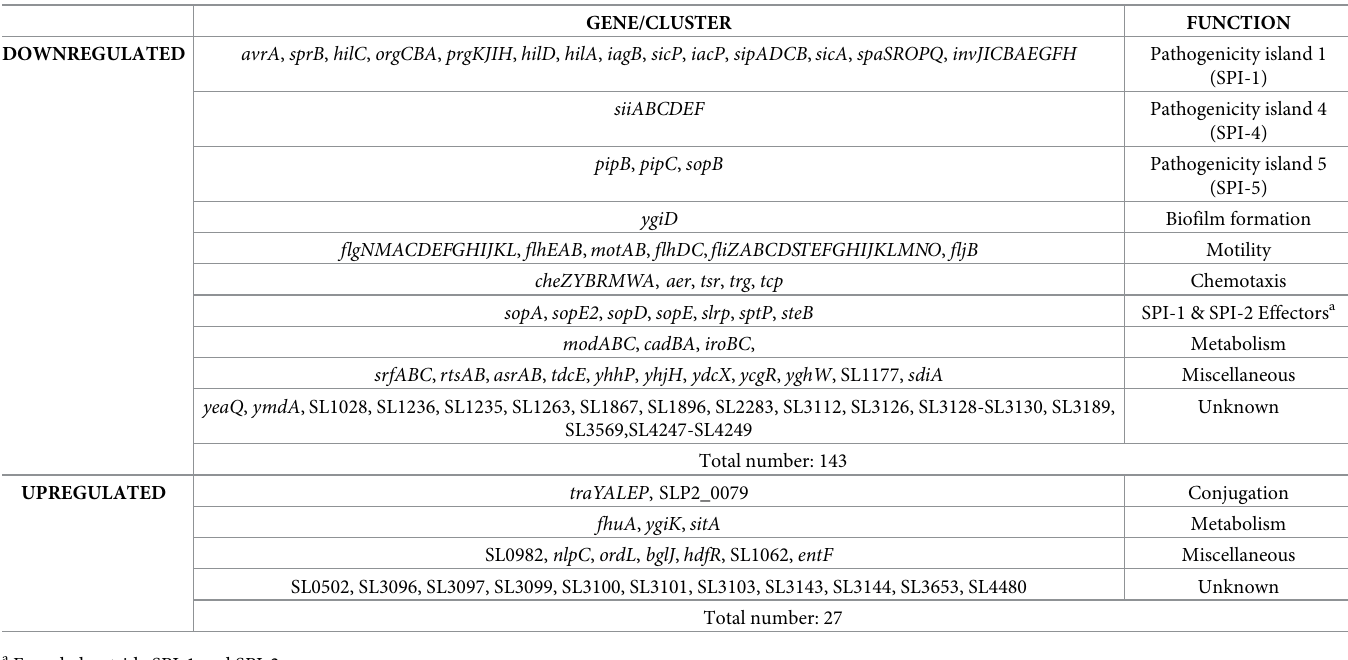
Table 1. Genes regulated by StdE and/or